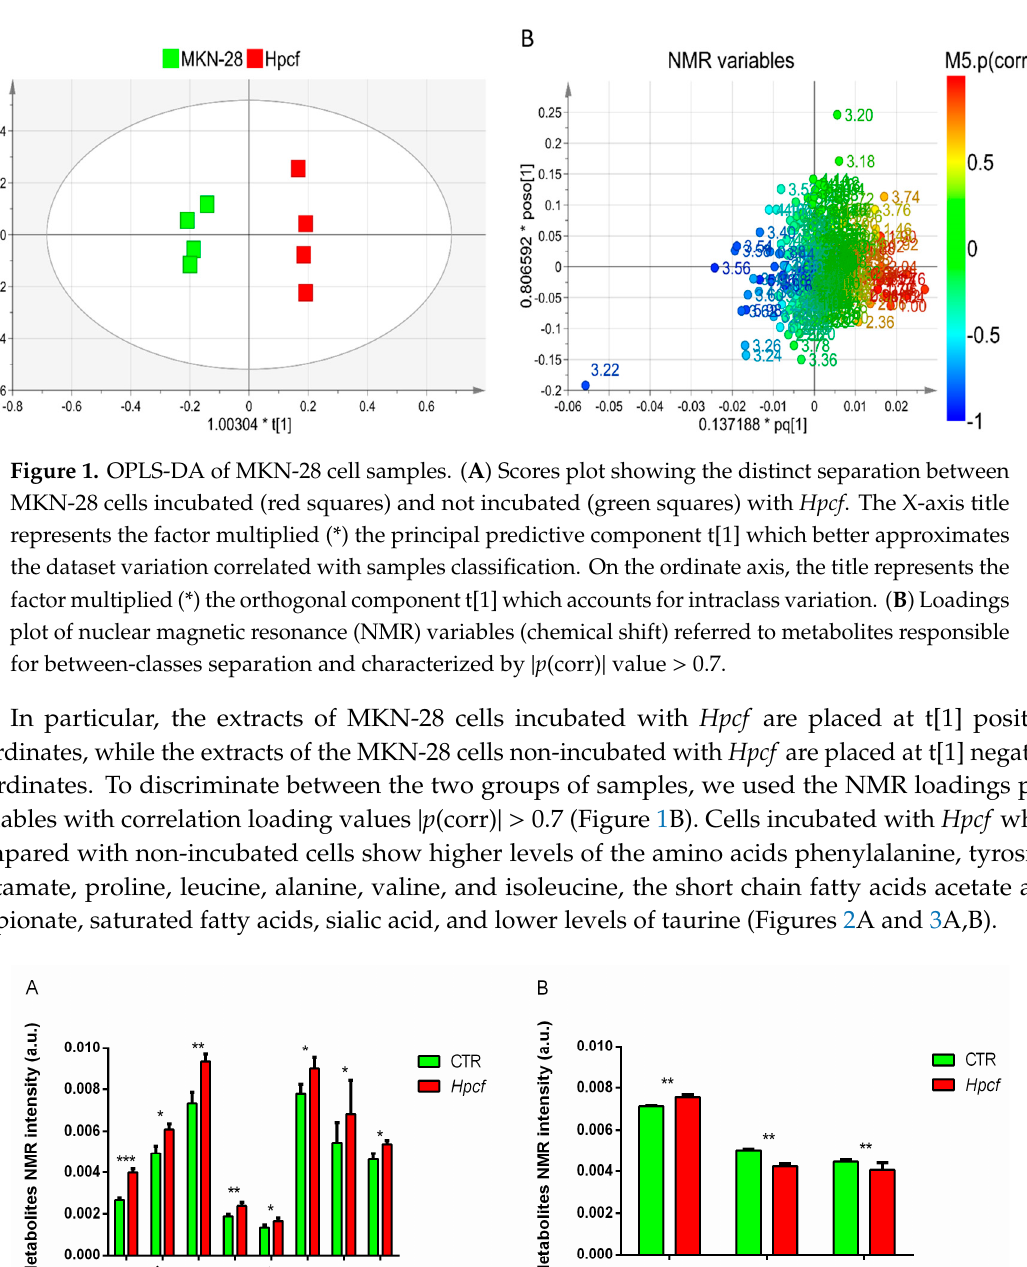
Figure 2. ( A ) Intracellular amino acid concentration differences (leucine, valine, isoleucine, phenylalanine, tyrosine, proline, and alanine) detected in MKN-28 cells incubated (red columns) or not incubated (green columns) with Hpcf . ( B ) Extracellular BCAA (leucine, isoleucine, and valine) concentration differences detected in culture medium of MKN-28 cells incubated (red columns) or not incubated (green columns) with Hpcf . Some Hp strains synthesizes isoleucine. Our strain is one of the strains that justify its upregulation. The X-axis reports a single amino acid and the Y-axis reports the bucket variation corresponding to the specific amino acid scaled to the total NMR spectral area. Intensity of amino acids is expressed in arbitrary units and represented as means ± SD (* p < 0.5, ** p < 0.01, *** p < 0.001) calculated from two experiments in which each is performed in quadruplicate.